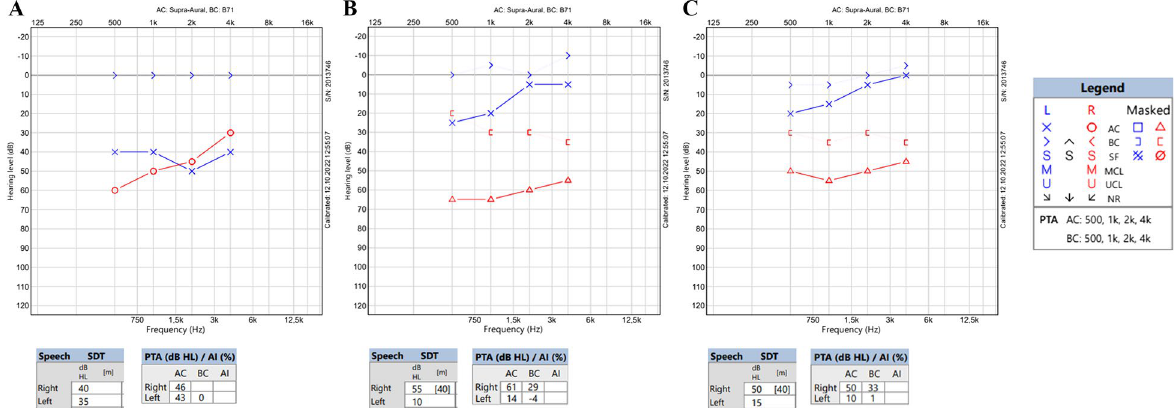
Fig. 4 Pure-tone audiometry results. A Initial audiological evaluation. B Audiological evaluation results after 2 months. C Audiological evaluation results after 5